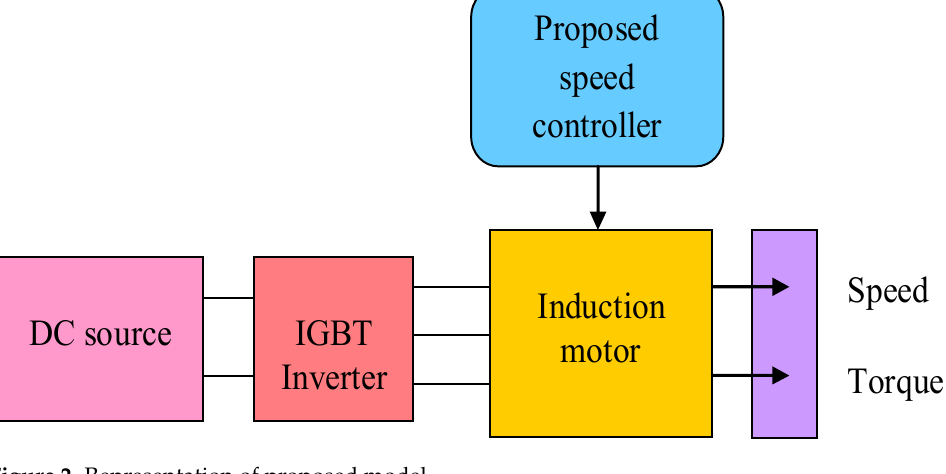
Figure 2. Representation of proposed model.